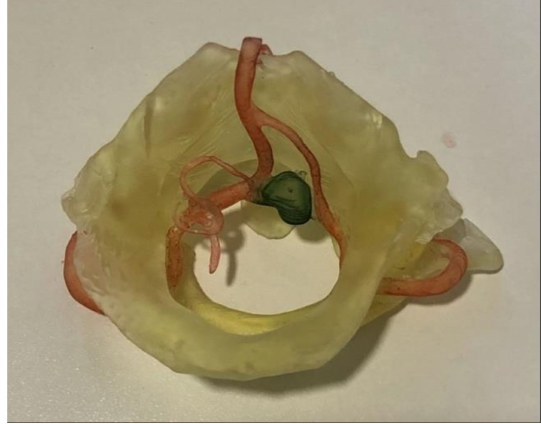
Figure 4. 3D printed model of a PICA aneurysm.